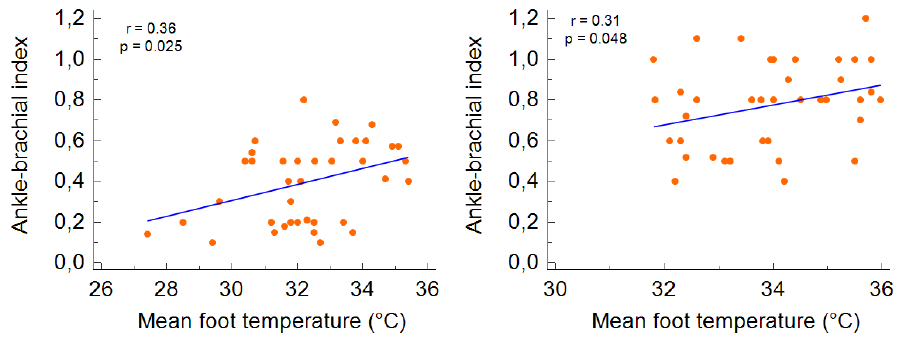
Figure 2. The correlation between the mean foot temperature and ABI before the revascularization in the more impaired foot ( left ) and the less impaired foot ( right ).